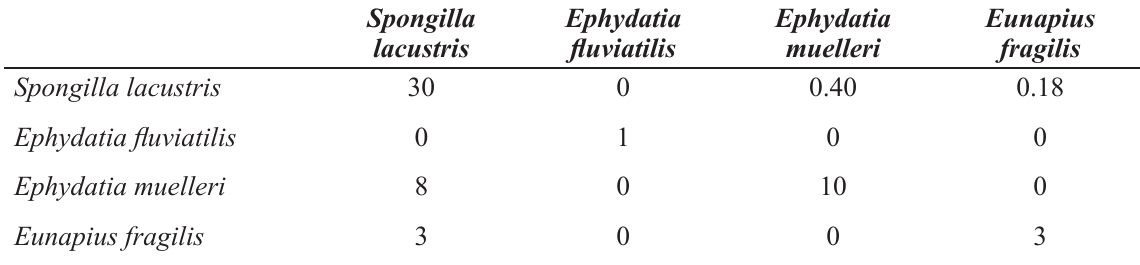
Table 2. Co-occurrence of freshwater sponges at different sites in the present study. On the diagonal are the number of sites where the species was found, lower triangle gives the number of co-occurrences, and upper diagonal shows Sørensen-Dice indices of species association (ranging from 0 – never found together to 1 – always found together). At two sites the three species Spongilla lacustris (Linnaeus, 1759), Ephydatia muelleri (Lieberkühn, 1856) and Eunapius fragilis (Leidy, 1851) were found together; at no site did all four species